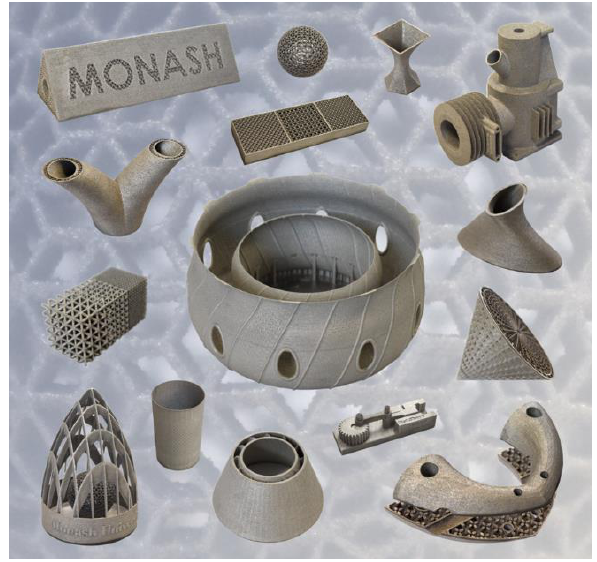
Figure 4. Examples of parts with complex geometries made by powder bed AM. Figure courtesy of Prof. Xinhua Wu, Monash University, Melbourne, Australia.